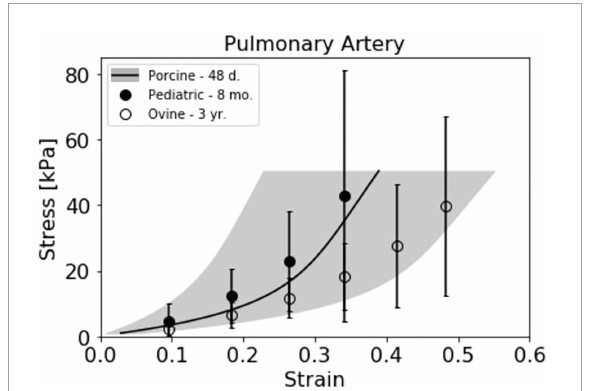
FIGURE7 Juvenile porcine pulmonary artery (PA) stress response curve compared with pediatric relevant data sets. The strain averaged Yucatan PA data from the uniaxial testing method ( N = 4) is presented alongside 8 month old pediatric ( N = 1) and 3 year old ovine ( N = 4) stress response curves previously presented by Cabrera et al. (28). Stress response data from Cabrera et al. was estimated from the reported secant modulus averages for the respective